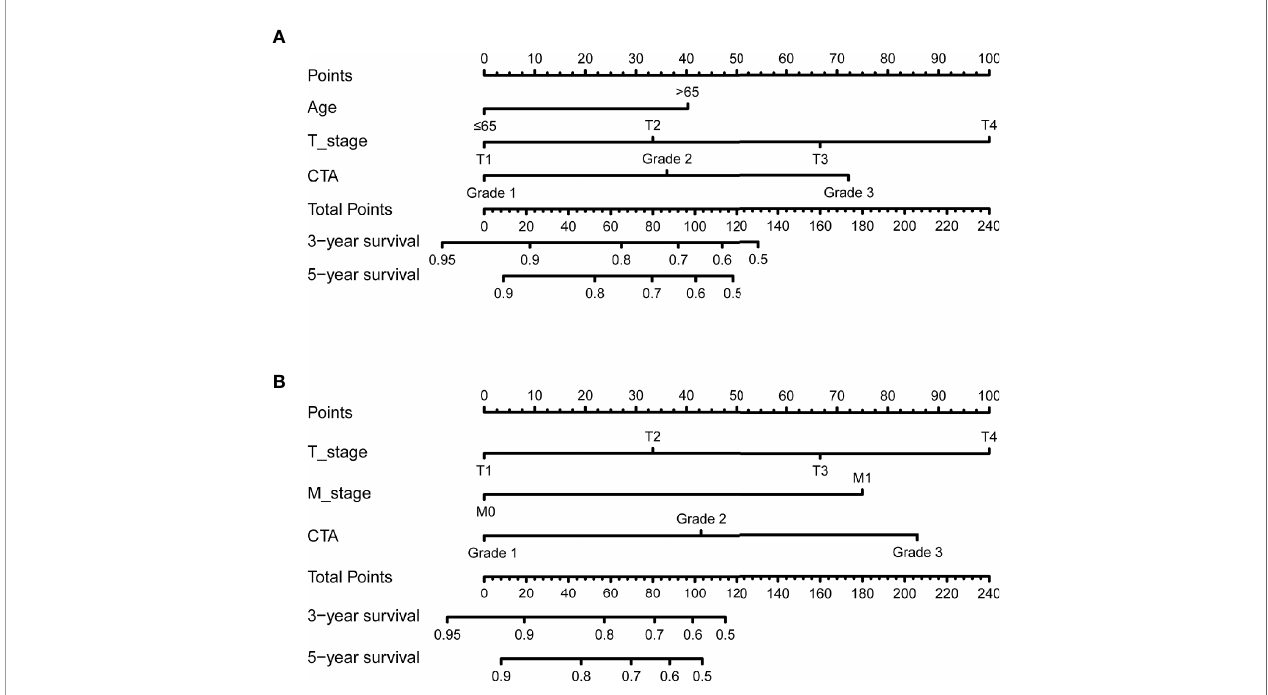
FIGURE 5 | The 3- and 5-year nomogram model for OS and DFS of bladder cancer (BCa) patients after radical cystectomy (RC) based on CTA grade (A, B) .